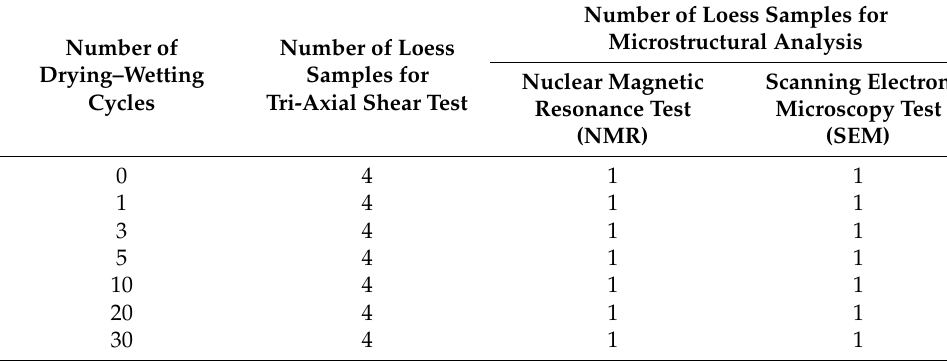
Table 4. Numbers of the loess samples in different tests.